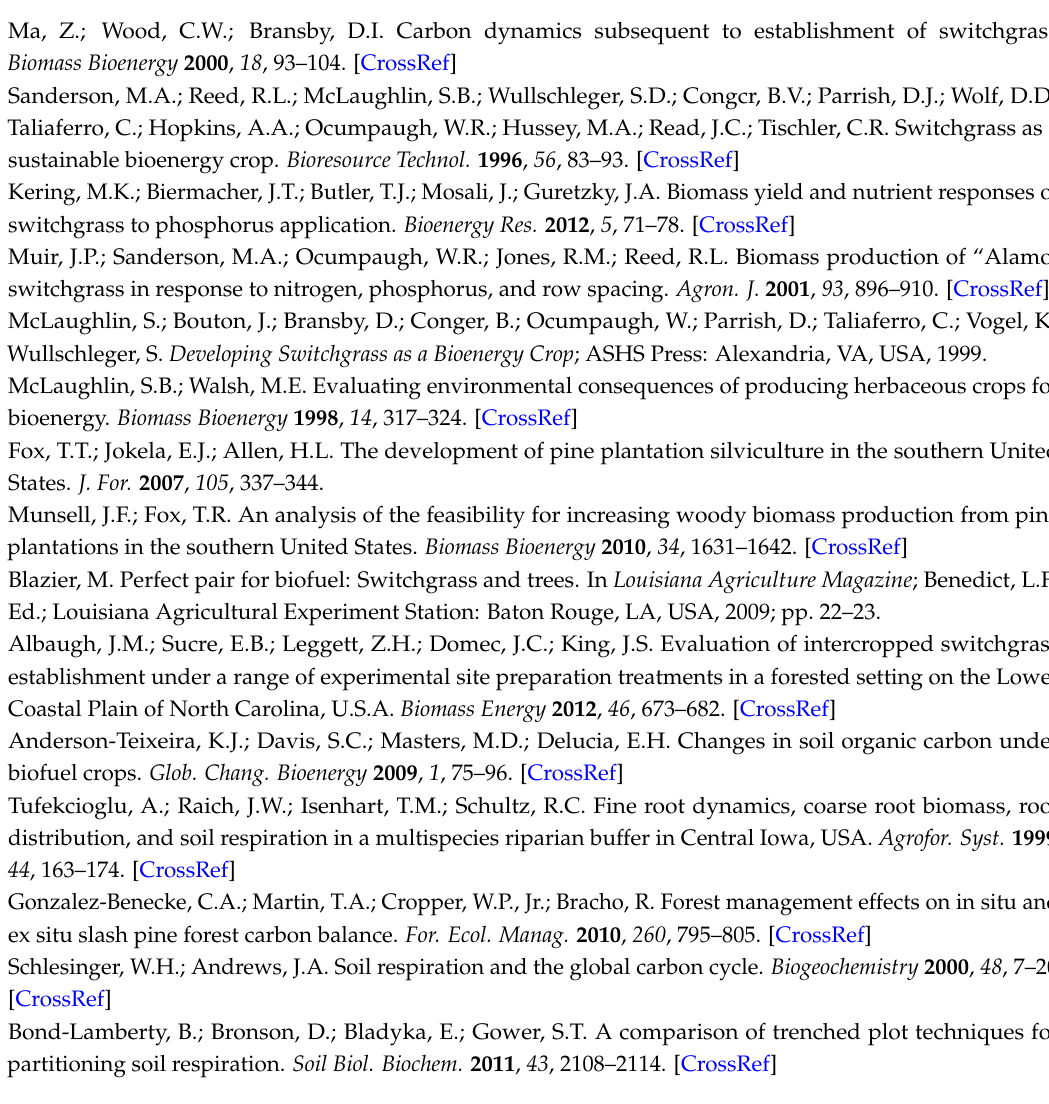
Figure S1: A conceptual diagram representing main treatments: ( A ) pure pine: bed (P-B); ( B ) pine + switchgrass intercrop: bed (PSG-B), edge (PSG-E), interbed (PSG-I); ( C ) pure switchgrass (SG). Figure S2: Mean soil moisture (in the top 12 cm) between 10 January 2012 to 19 January 2013 in a four-year-old switchgrass and loblolly